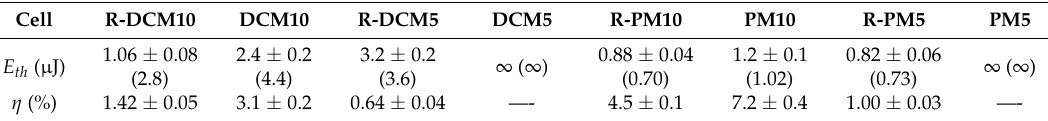
Table 4. Experimental threshold energies E th and slope efficiencies η for the different laser cavities studied. In parenthesis the theoretical E th values according to Equation